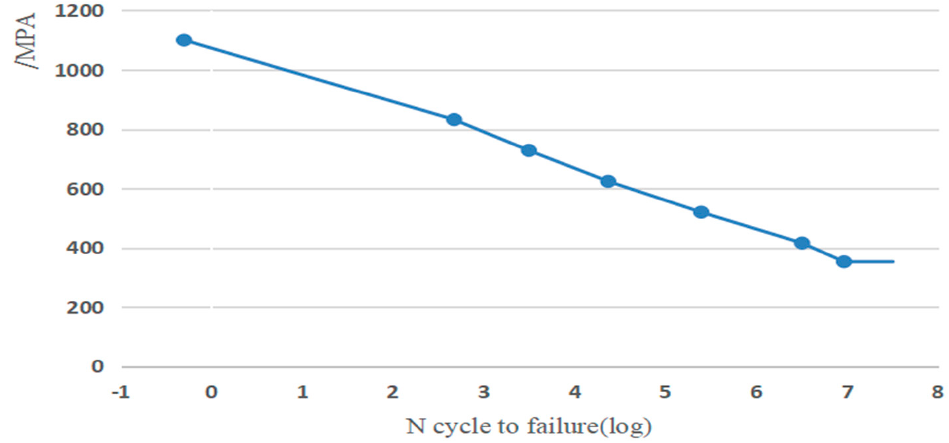
Figure 4. S–N curve.